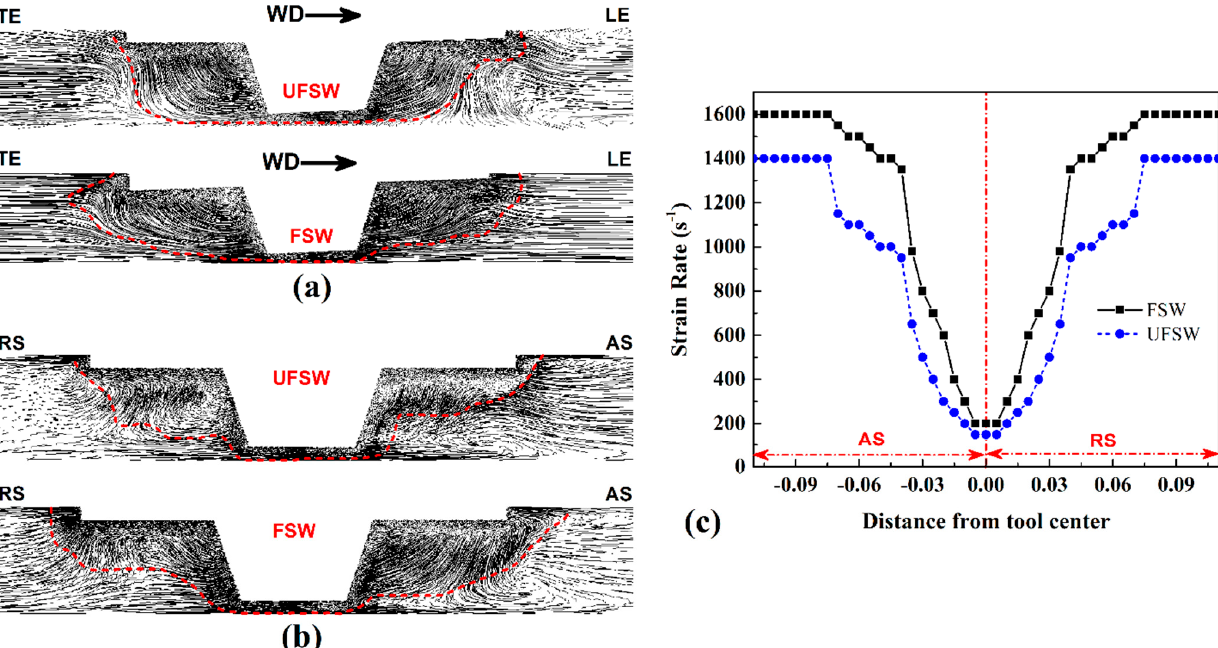
Figure 6. Streamline flow in ( a ) longitudinal section and ( b ) cross section view. ( c ) Variations of strain rate in SZ of the FSW and UFSW samples.